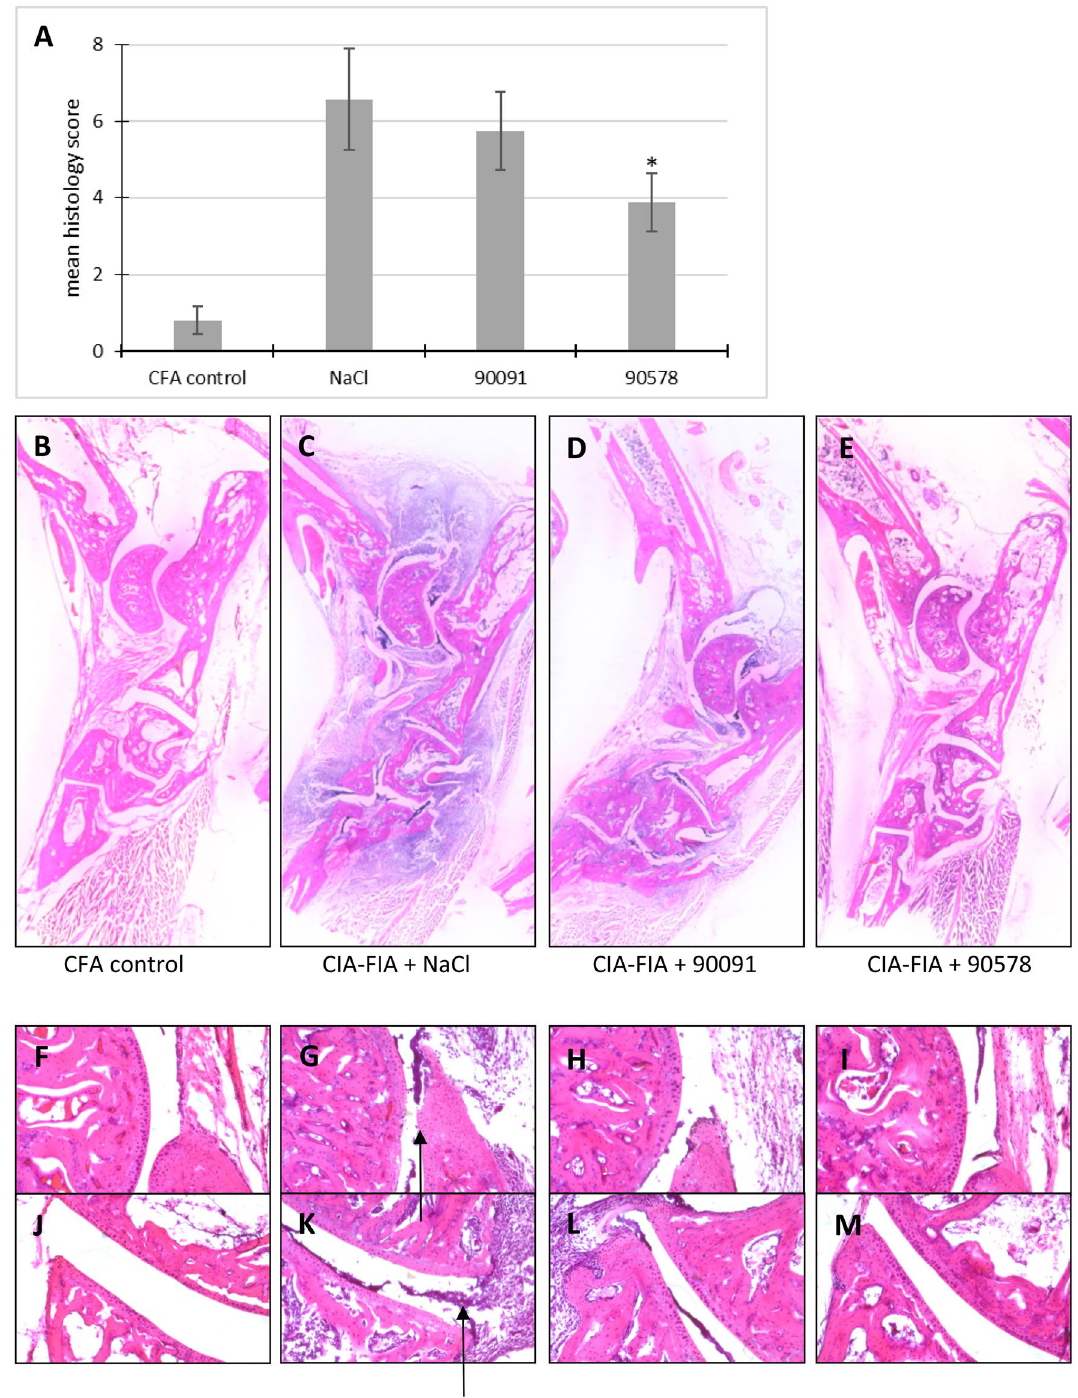
Figure 4. Histological findings in the therapy study with peptides 90091 and 90578 or NaCl. ( A ) Mean histology scores of CFA-immunized control mice and FIA-CIA mice treated with peptides 90091 (N = 8 independent animals), 90578 (N = 8) or NaCl (N = 7). Error bars indicate SEM; *p < 0.05 (all values compared to NaCl control mice). ( B – E ) Overview of the tarsus, ( F – I ) ankle joint, ( J – M ) tarsal joint. ( B , F , J ) Mice immunized with CFA alone, ( C , G , K ) FIA-CIA immunized mice treated with NaCl, ( D , H , L ) FIA-CIA immunized mice treated with peptide 90091, ( E , I , M ) FIA-CIA immunized mice treated with peptide 90578. Arrows indicate histological changes in the FIA-CIA